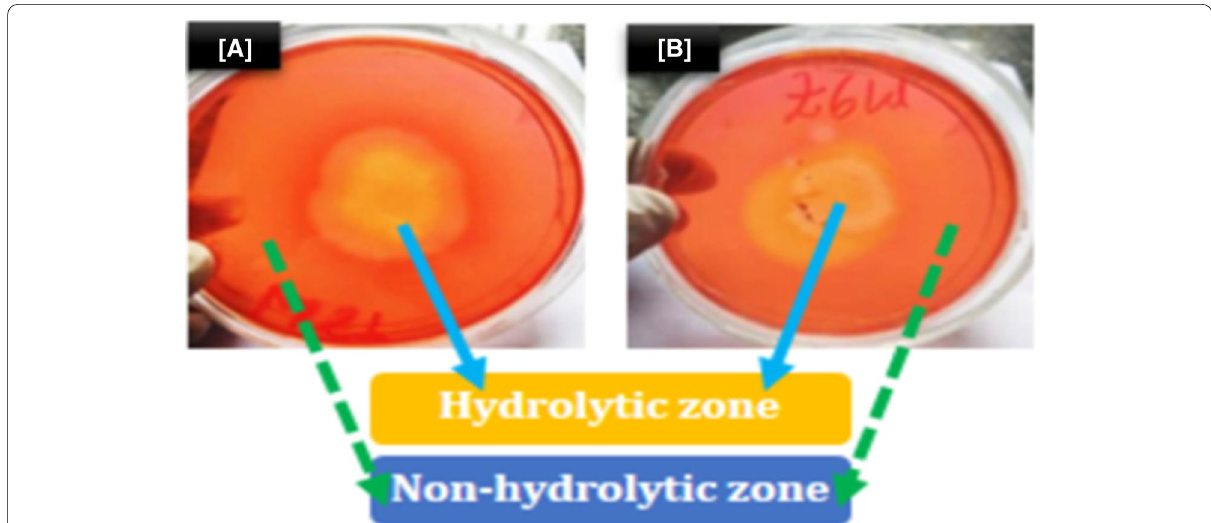
Fig. 1 Cellulose-degradation/CMC/ by M21WG [ A ] and Z6WG [ B ] bacterial isolates /reresentaives/